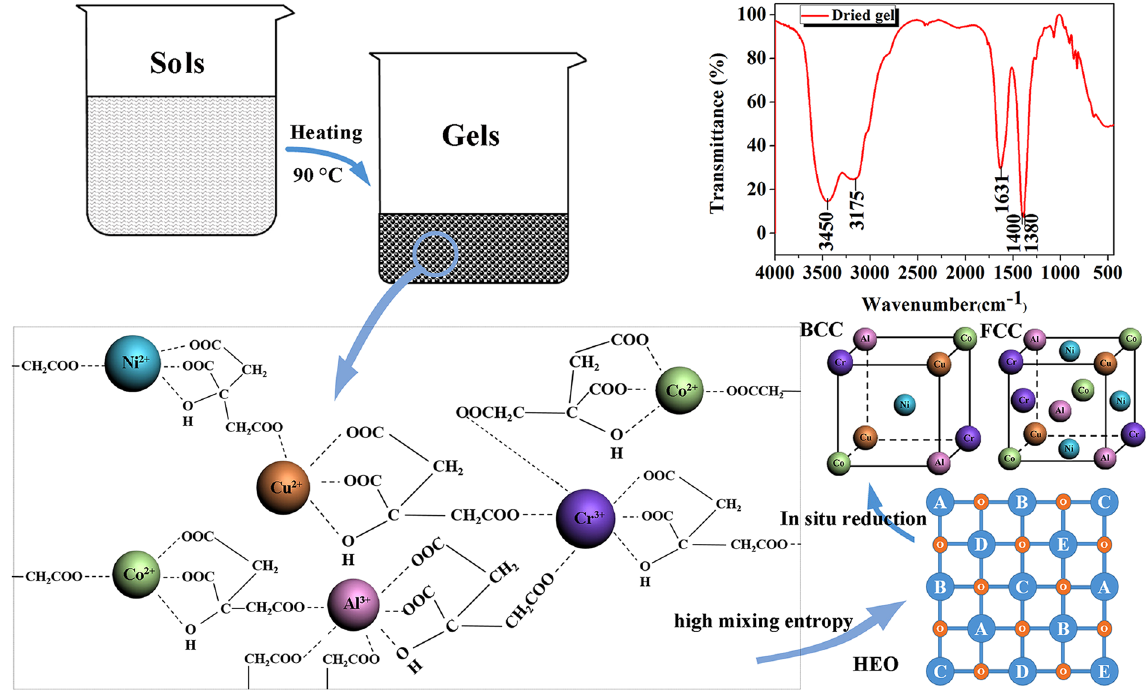
Figure 3. Schematic illustration of the sol–gel combustion process and the FTIR pattern for the dried